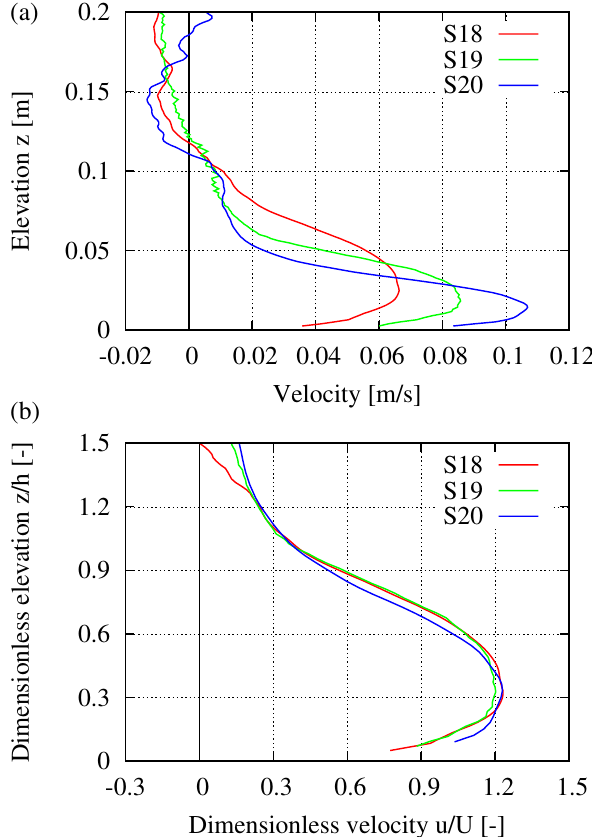
Figure 14. Dimensional (a) and dimensionless (b) comparison be- tween density current velocity profiles with di ff erent density excess ( ∆ ρ/ρ ) and same flow discharge ( q 0 = 0 . 0026 m 2 / s ) at the inlet (ex- periments S18, S19 and S20).The profiles are measured in cross section C5.